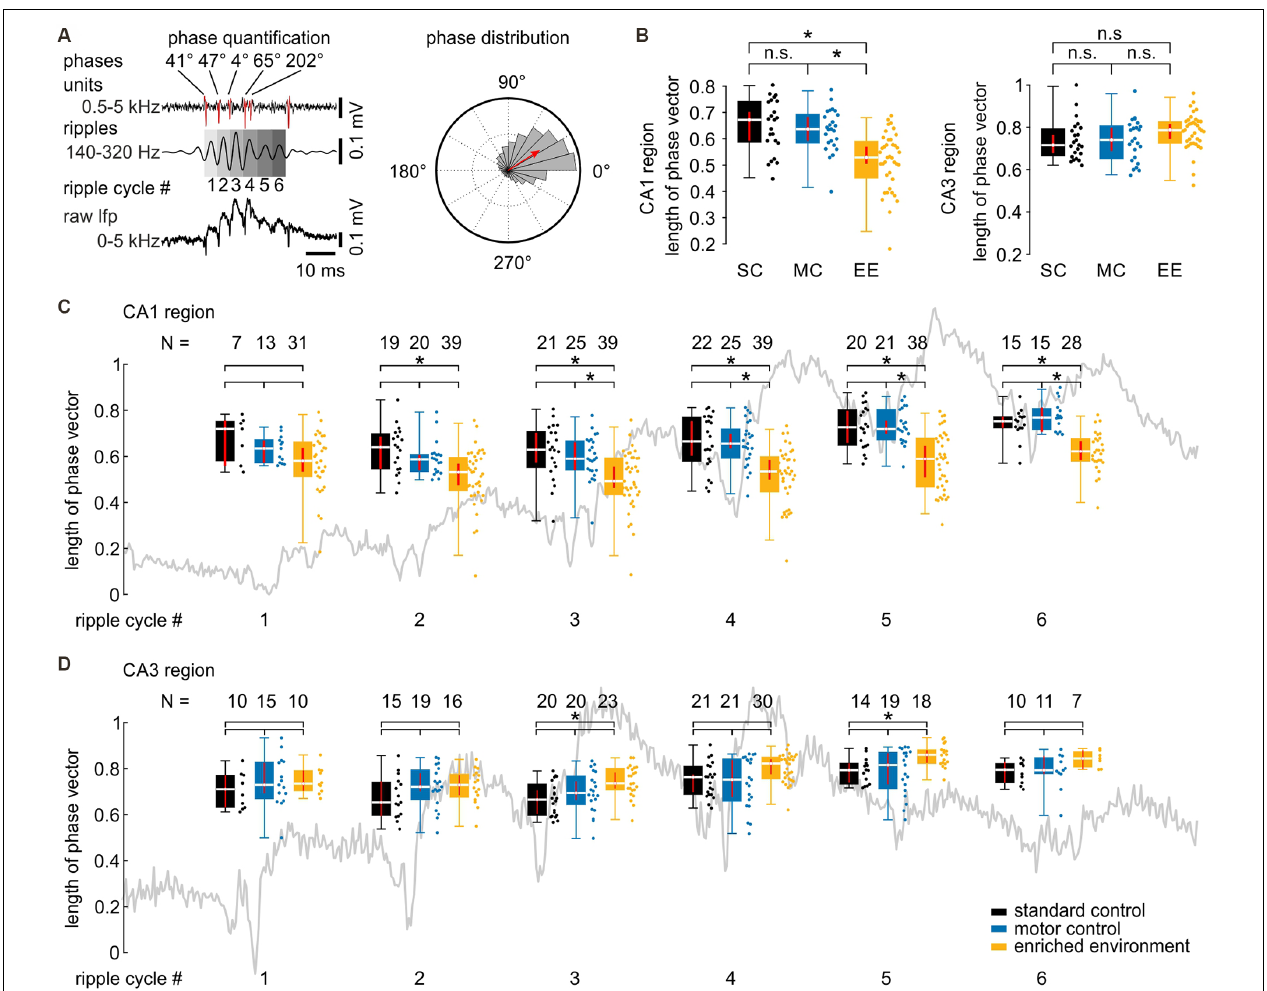
FIGURE 3 | Coupling precision between spikes and field ripples is decreased after environmental enrichment. (A) Schematics of firing precision quantification. Each ripple cycle was divided into 360 ◦ starting with the first detectable ripple trough of a sharp wave-ripple complex. Spike time was measured as the phase within the respective ripple cycle (left panel, upper values). Precision was then quantified by the length of the normalized mean vector (red arrow in the right panel). (B) Firing precision is reduced in CA1 but not CA3 as can be seen by the decreased length of the phase vector. N = 23 slices from six mice for SC, N = 25 slices from five mice for MC, and N = 39 slices from eight mice for EE. (C) EE-induced differences in firing precision develop over the time course of SPW-R. (D) The CA3 region shows no differences in firing precision between EE and the two control groups. The N values above the graphs show the number of slices included in the analysis of the respective ripple cycle (minimum of 33 spikes, see “Materials and Methods” section; length of normalized mean vector in CA1 [median and {confidence interval}]: ripple cycle #1: SC: 0.72 {0.56, 0.76}; MC: 0.64 {0.57, 0.67}; EE: 0.58 {0.53, 0.64}; ripple cycle #2: SC: 0.64 {0.55, 0.69}; MC: 0.59 {0.54, 0.61}; EE: 0.53 {0.47, 0.57}; ripple cycle #3: SC: 0.63 {0.57, 0.70}; MC: 0.59 {0.54, 0.66}; EE: 0.49 {0.46, 0.55}; ripple cycle #4: SC: 0.67 {0.59, 0.75}; MC: 0.66 {0.61, 0.70}; EE: 0.53 {0.50, 0.58}; ripple cycle #5: SC: 0.73 {0.66, 0.80}; MC: 0.72 {0.70, 0.76}; EE: 0.59 {0.51, 0.65}; ripple cycle #6: SC: 0.75 {0.72, 0.77}; MC: 0.77 {0.71, 0.81}; EE: 0.62 {0.58, 0.67}). Asterisks denote p -values < 0.05 from post-hoc testing following a significant Kruskal-Wallis test. Red lines depict the confidence intervals of the median assessed by bootstrapping. n.s., not